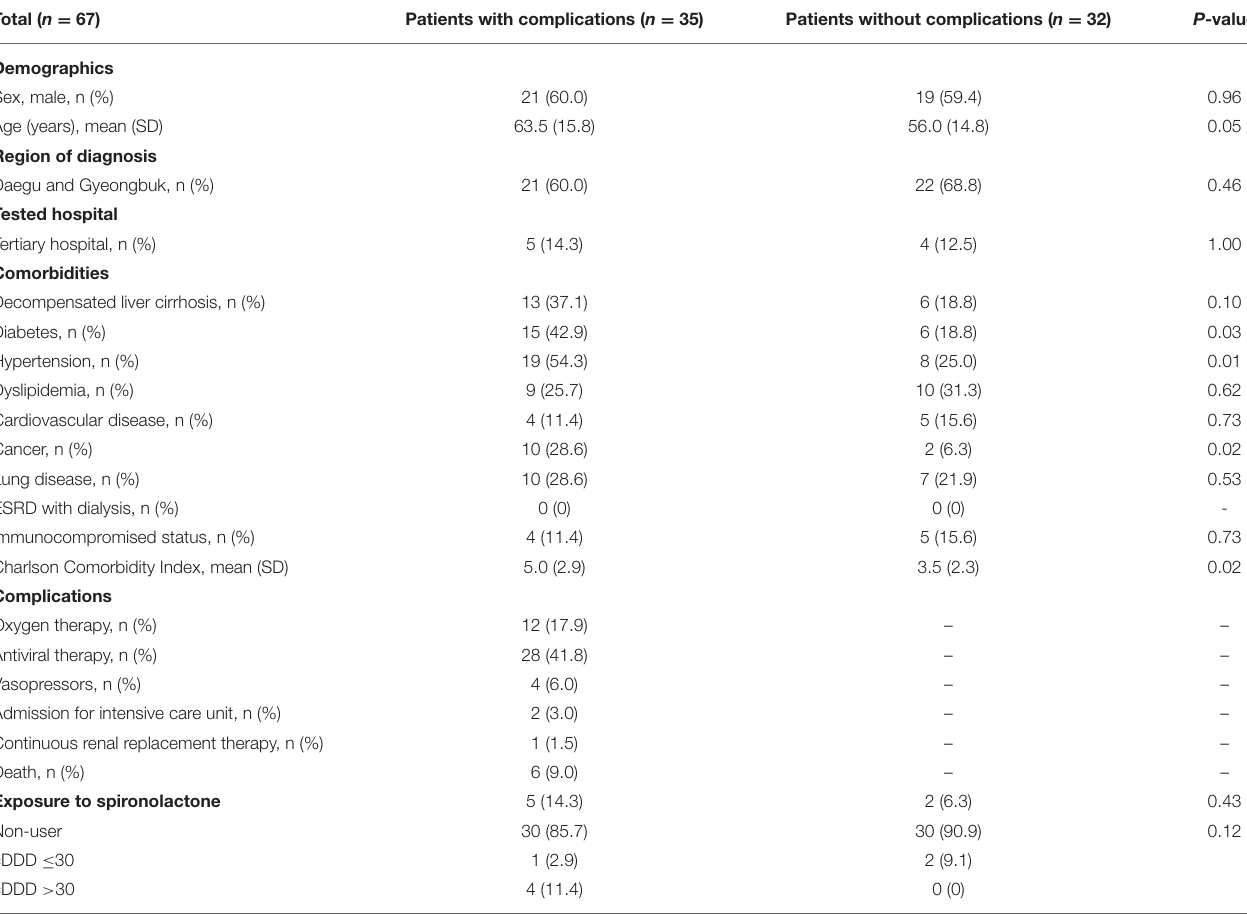
TABLE 3 | Baseline characteristics of patients with liver cirrhosis and